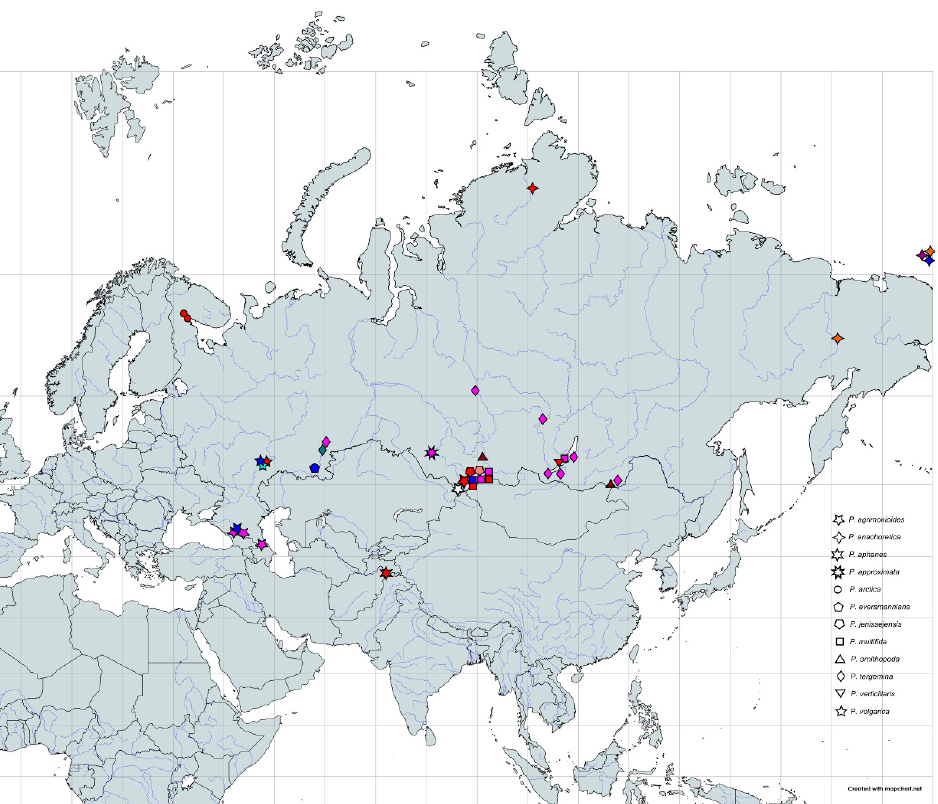
Figure 3. Geographical distribution of studied species and populations of Potentilla multifida agg. Colors of symbols follow Figure 1. Closely situated localities of the same species are lumped when represented by the same haplotype lineage. Localities of P. tergemina on railroads outside its natural range are not shown.